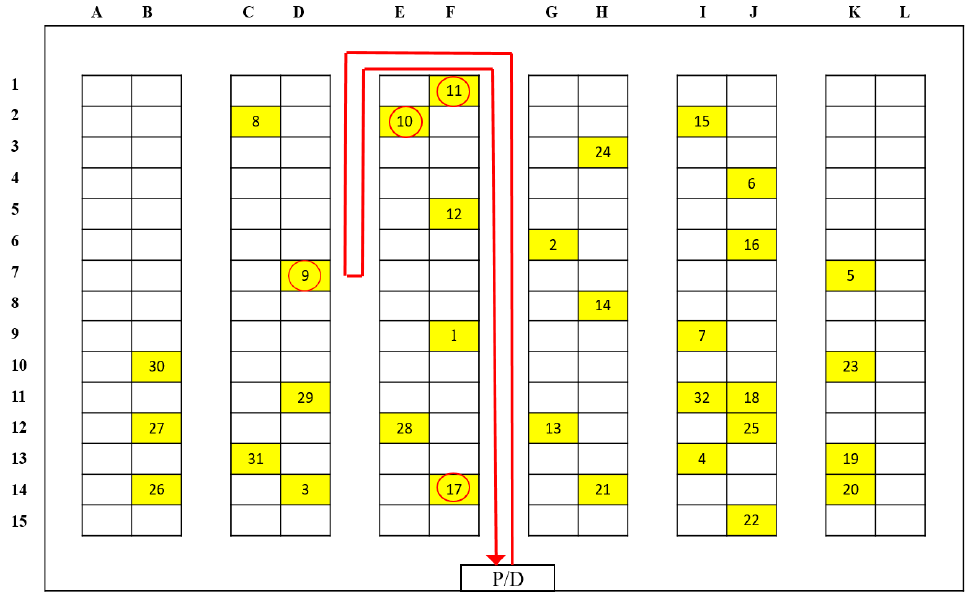
Figure 7. The picking route of batch 1.